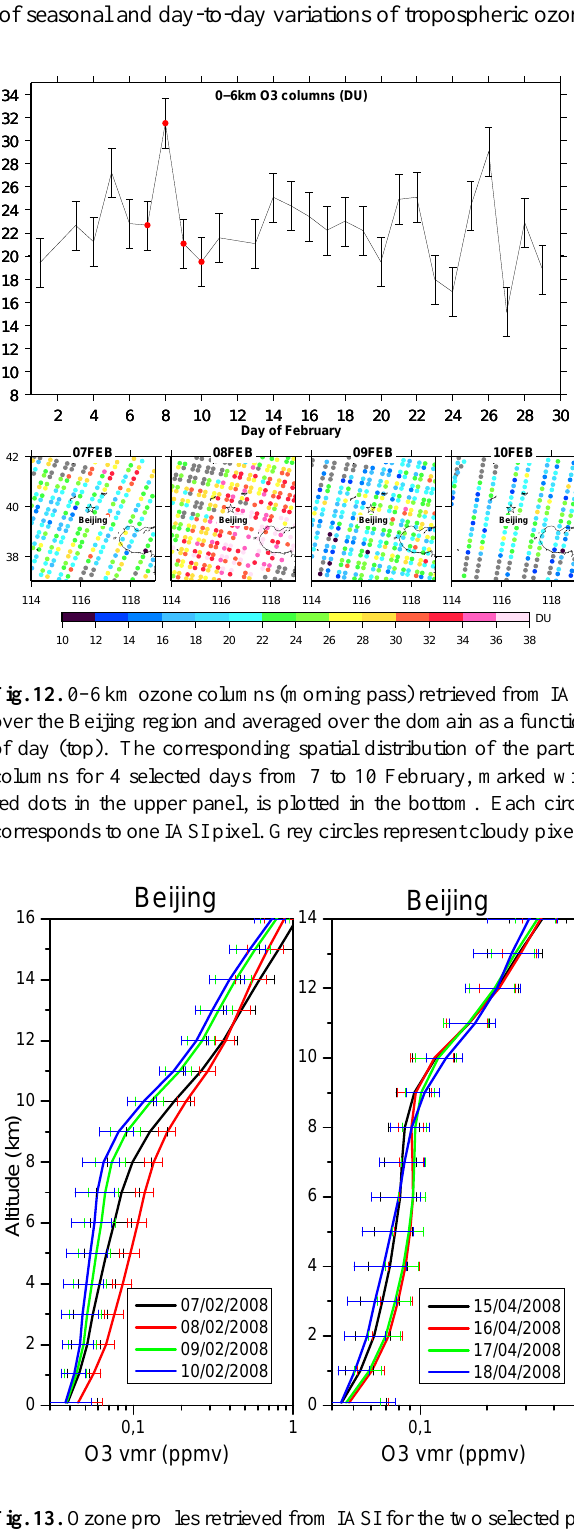
Figure 13. Ozone profiles retrieved from IASI for the two selected periods with enhanced ozone events over Beijing. The ozone profiles retrieved for the morning overpasses are averaged over the Beijing area. The error bars corresponds to the standard deviation of the mean.